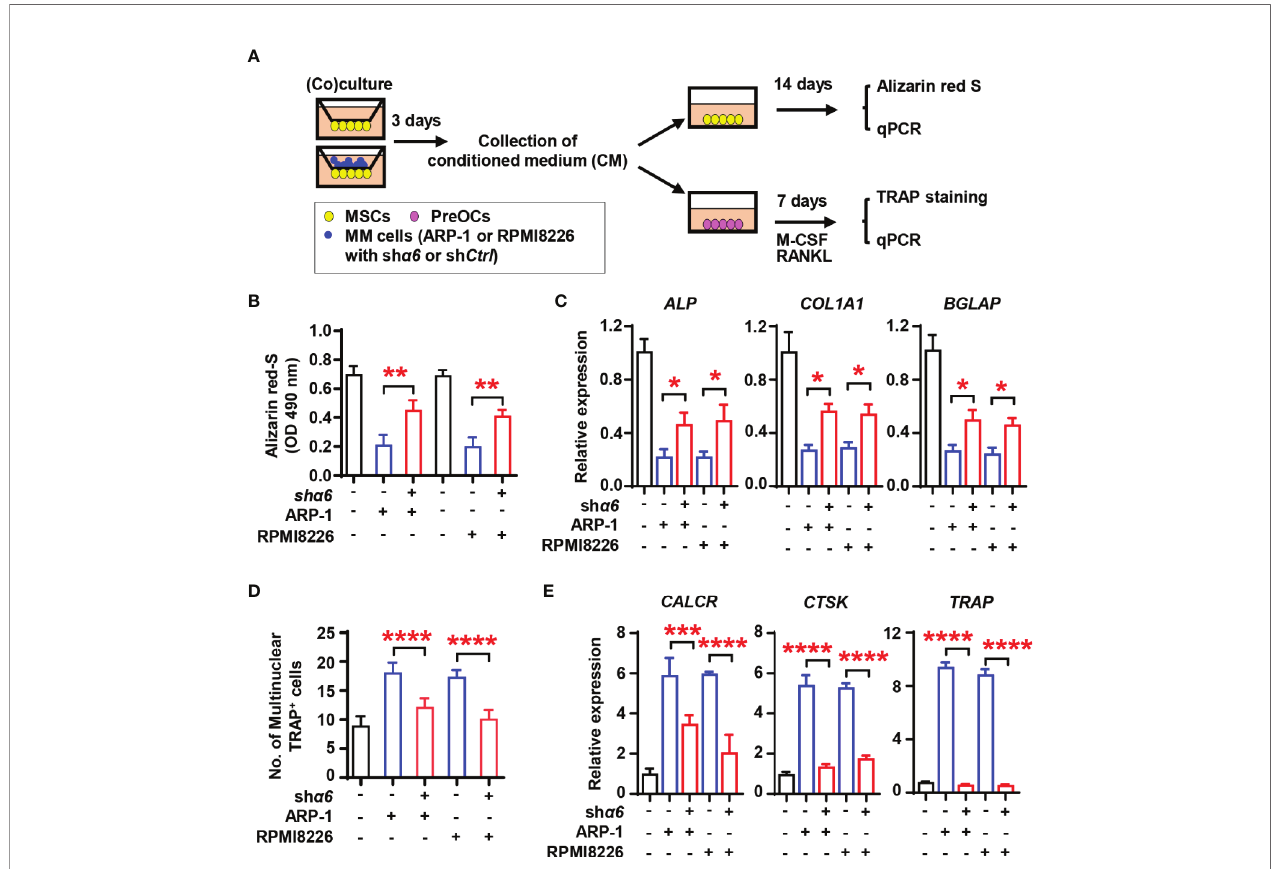
FIGURE 3 | Myeloma cell integrin a 6 inhibits osteoblast differentiation in vitro . (A) The schematic of coculture systems of MSCs with myeloma cells. (B, C) MSCs were cocultured with myeloma cells. RNAs were extracted for qPCR analysis of osteoblast marker genes and cells were stained with Alizarin red S staining to assess osteoblastogenesis. Shown are the summarized data of Alizarin red S staining (B) , and the relative expression of BGLAP , ALP , and COL1A1 genes in MSCs (C) . (D, E) preOCs were cocultured with myeloma cells. RNAs were extracted for qPCR analysis and cells were stained with TRAP to access osteoclastogenesis. Shown are the schematic of coculture systems of preOCs with myeloma cells (D) , numbers of multinuclear ( ≥ 3) TRAP + cells (E) , and the relative expression of CALCR , CTSK , and TRAP in precursors of osteoclasts. Data shown as averages ± SD is a representative of three independent experiments. * P < 0.05. ** P < 0.01. *** P < 0.001. **** P < 0.0001. All P values were determined using one-way